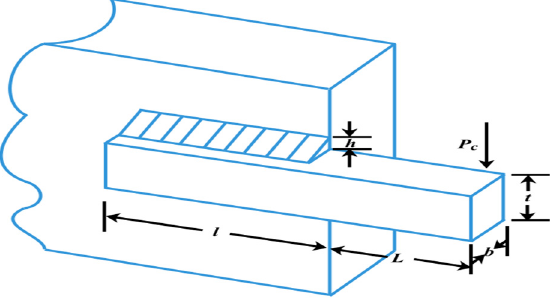
Figure 7. Design of a welded beam problem.